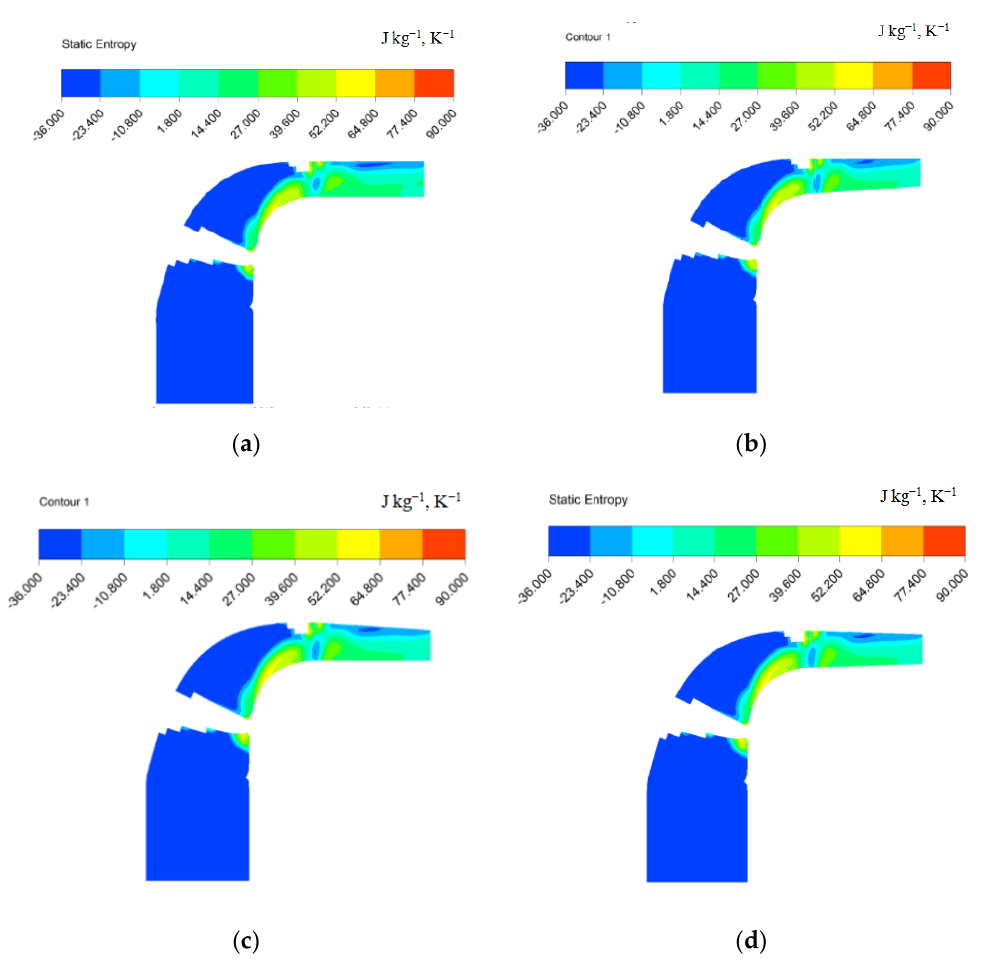
Figure 14. Meridional surface entropy distribution at 1.125 relative mass flow ( a ) parallel; ( b ) convergence from shroud; ( c ) convergence from hub; ( d ) equal convergence from shroud and hub.